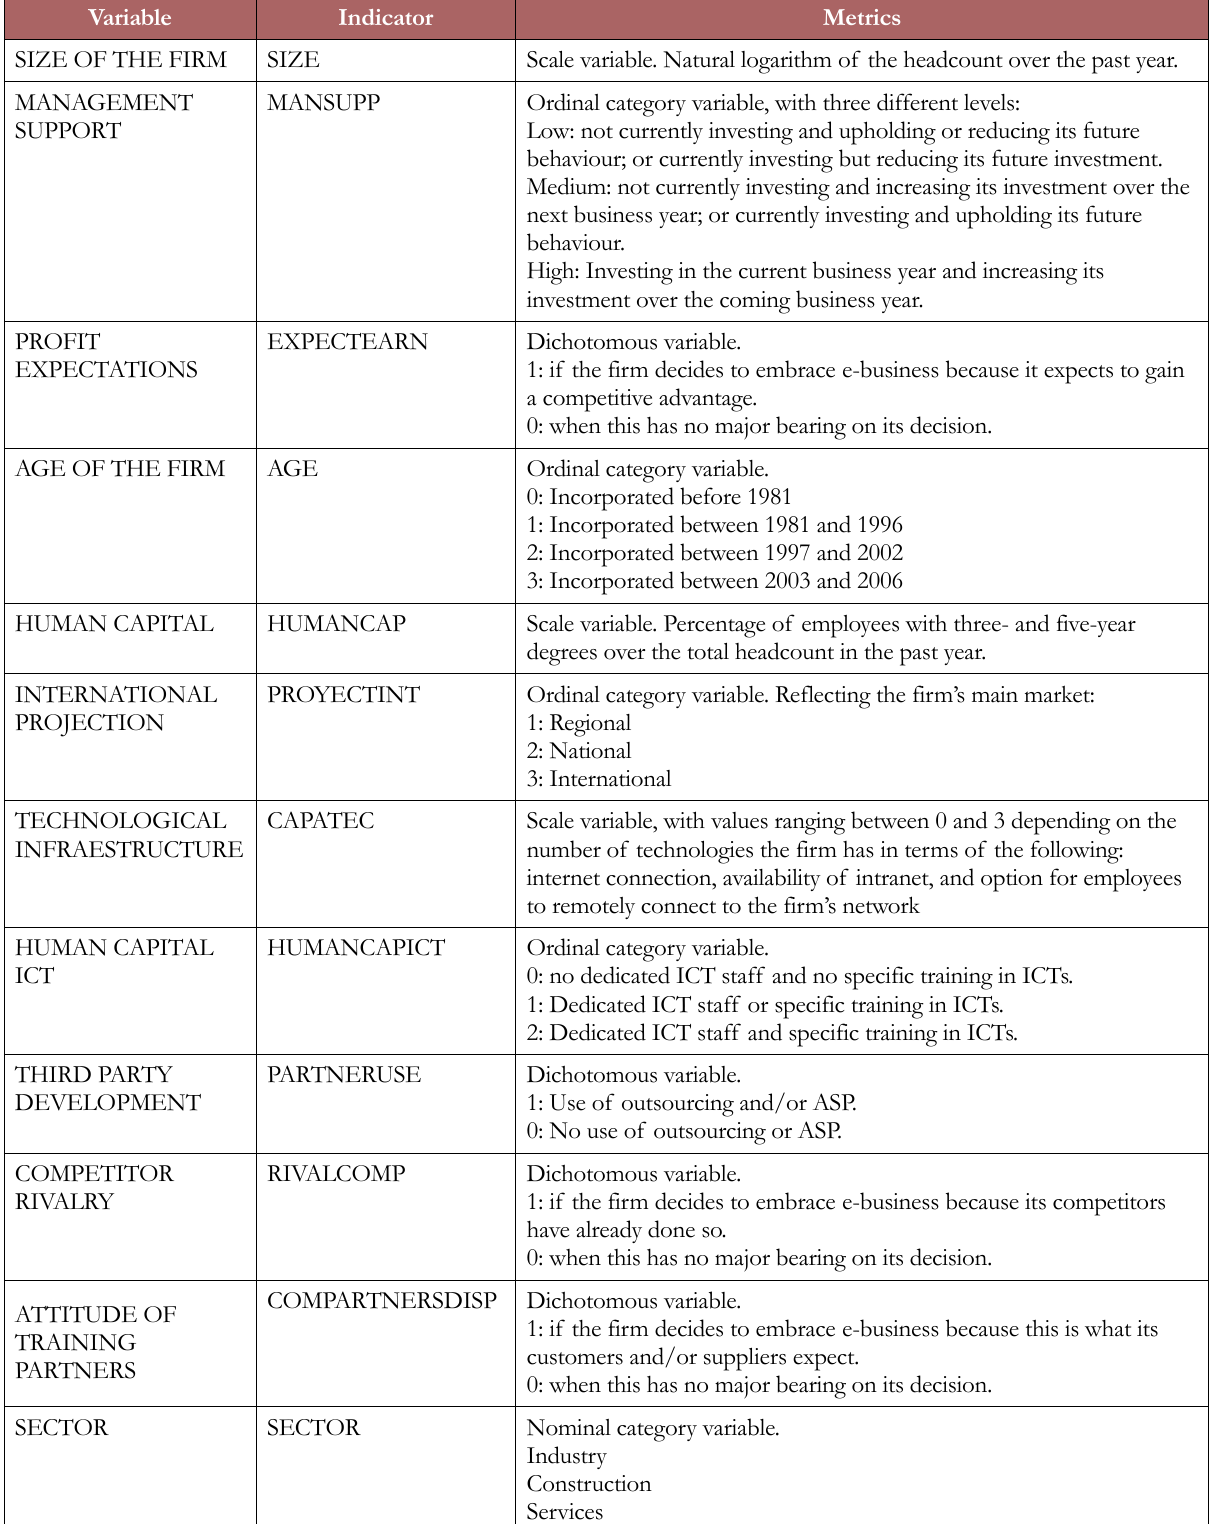
Table 3. Metrics of the independent variables used in the analysis